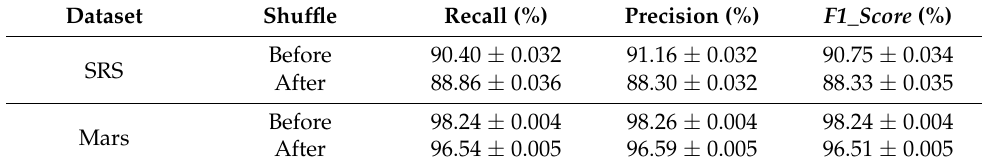
Table 5. Validation experiments for spatial topological structure information. Dataset Shuffle Recall